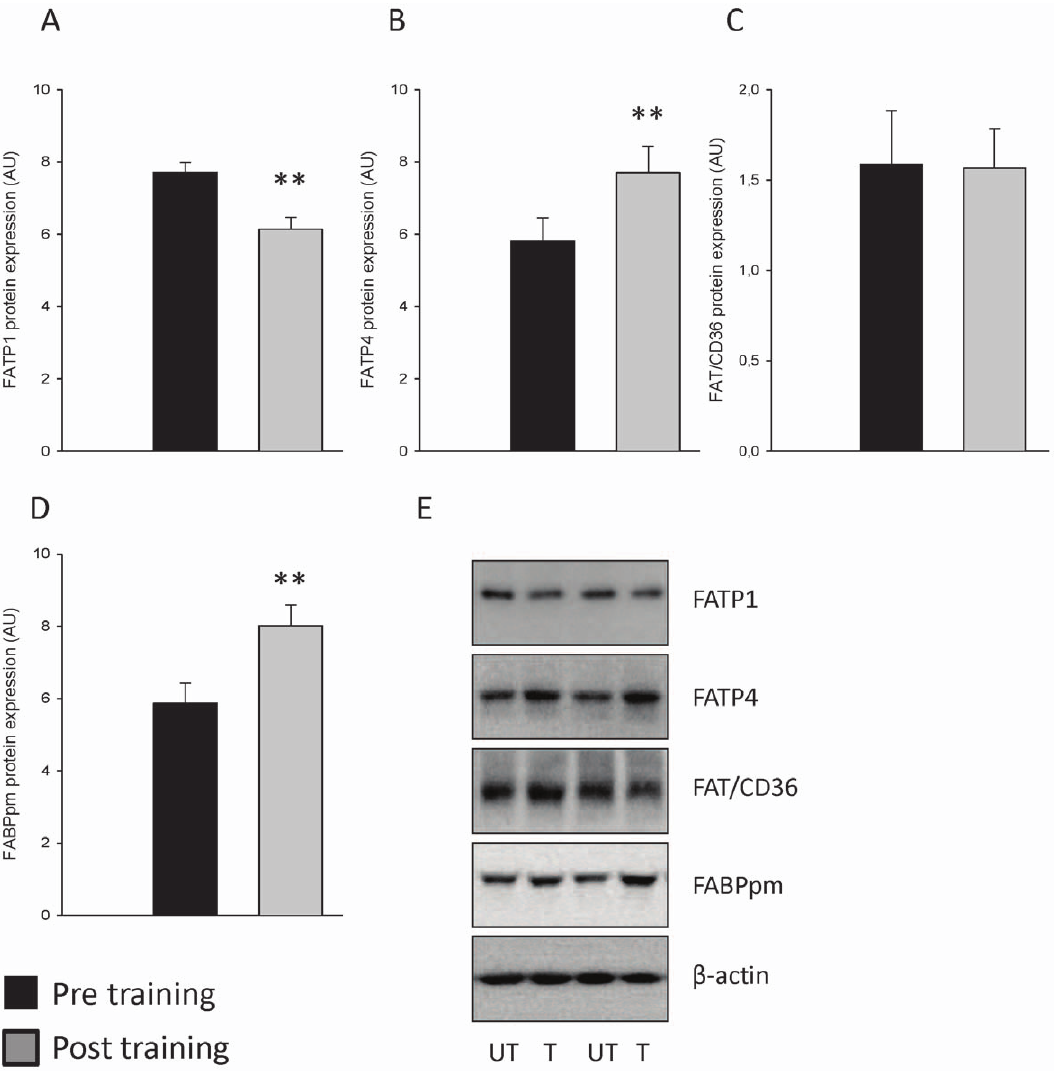
Figure 2. Divergent effects of exercise training on membrane bound lipid binding protein expression in human skeletal muscle. Protein concentration of total crude membrane (TCM) fractions before and after 8 weeks of exercise training were determined and equal protein amounts were resolved by SDS-PAGE and membranes were immunoblotted using antibodies specific for FATP1, FATP4, FAT/CD36 and FABPpm. b - actin was run on membranes as control and was unchanged with exercise training. Eight weeks of endurance exercise training resulted in reduced FATP1 protein expression in skeletal muscle (A). In contrast, (B) FATP4 and (C) FABPpm protein expression was increased after the training intervention compared to before training. FAT/CD36 protein expression was similar before and after training (D). Representative Western blots of protein levels before (Pre) and after the exercise training period (Post) from the same subjects are shown (E). Black bars represents pre training values and grey bars represents post training values. **; p ,